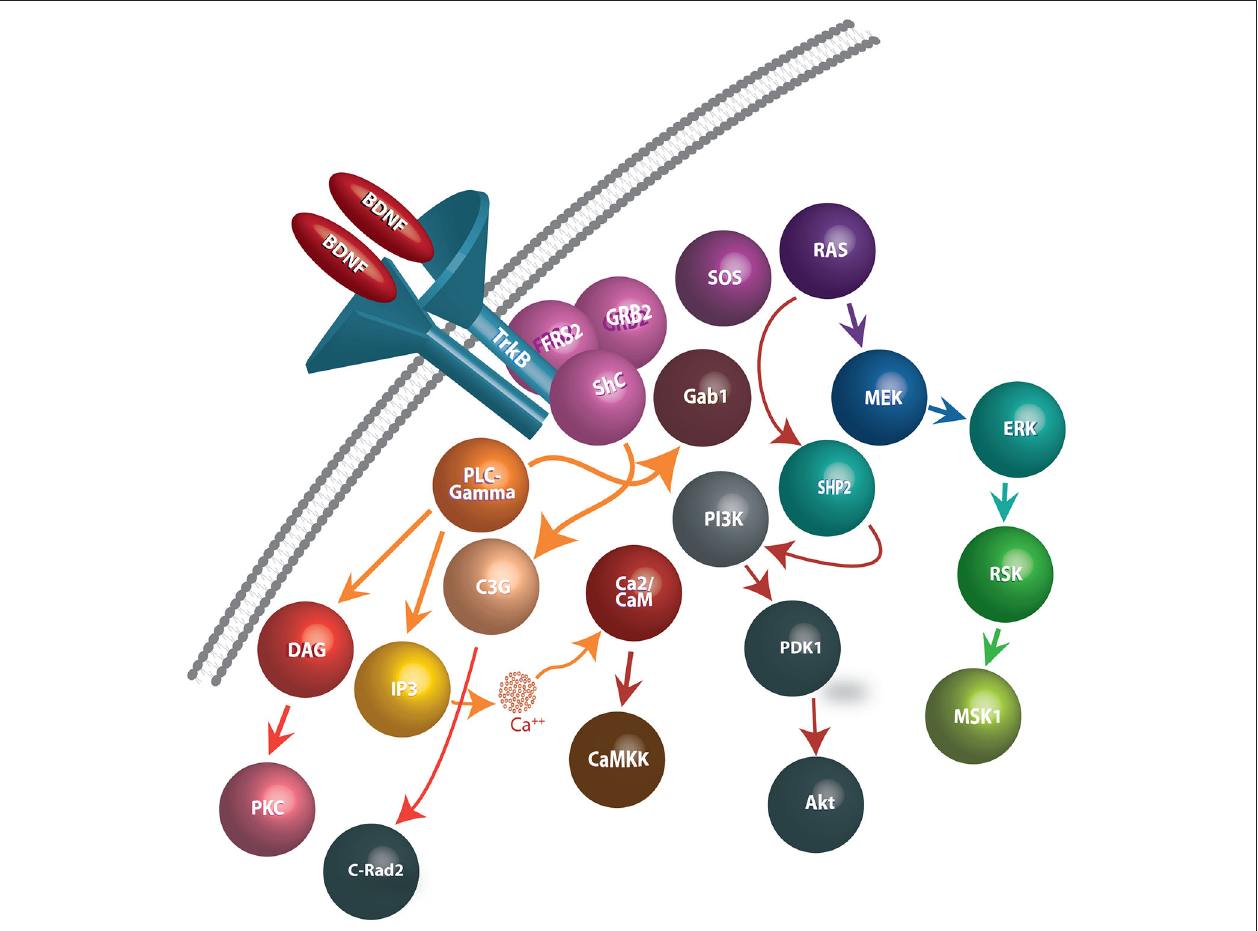
internal stores, DAG stimulates DAG-regulated protein kinase C isoforms. (2) Ras-MAP/erk signaling: Phosphorylation of Trk receptors provides a recruitment site for binding of the PTB domain of the adaptor protein, Shc. Shc recruits the adaptor protein, Grb2, and complexes with SOS, an exchange factor for Ras (and Rac). Activated Ras stimulates signaling through several downstream pathways, including those mediated by PI3-kinases, Raf, and p38MAP kinase. (3) PI-3 kinase signaling: Phosphatidylinositides are generated by PI3-kinase and activate phosphatidylinositide-dependent protein kinase (PDK-1). PDK-1 activates the protein kinase Akt (also known as PKB), which then phosphorylates several proteins important in promoting cell